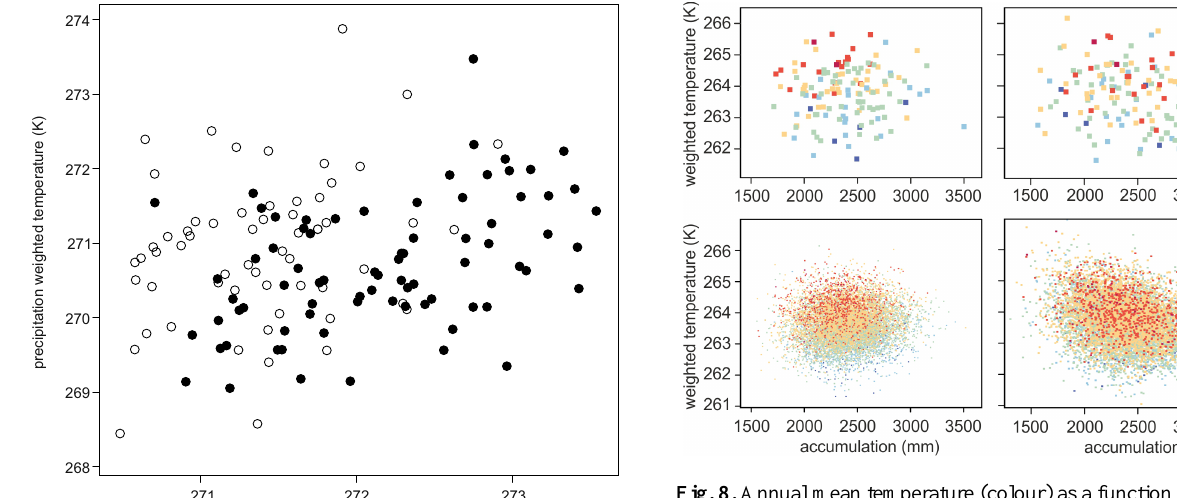
Fig. 8. Annual mean temperature (colour) as a function of accumu- lation and PWT in the virtual ice cores using the calendar (left) or cold point (right) year. Top: virtual ice core from 20CR. Bottom: virtual ice core from the Monte Carlo resampling of 20CR, 1871– 2008 (10000